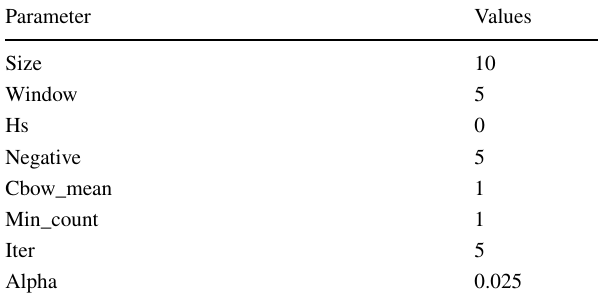
Table 3 Word2vec model parameter